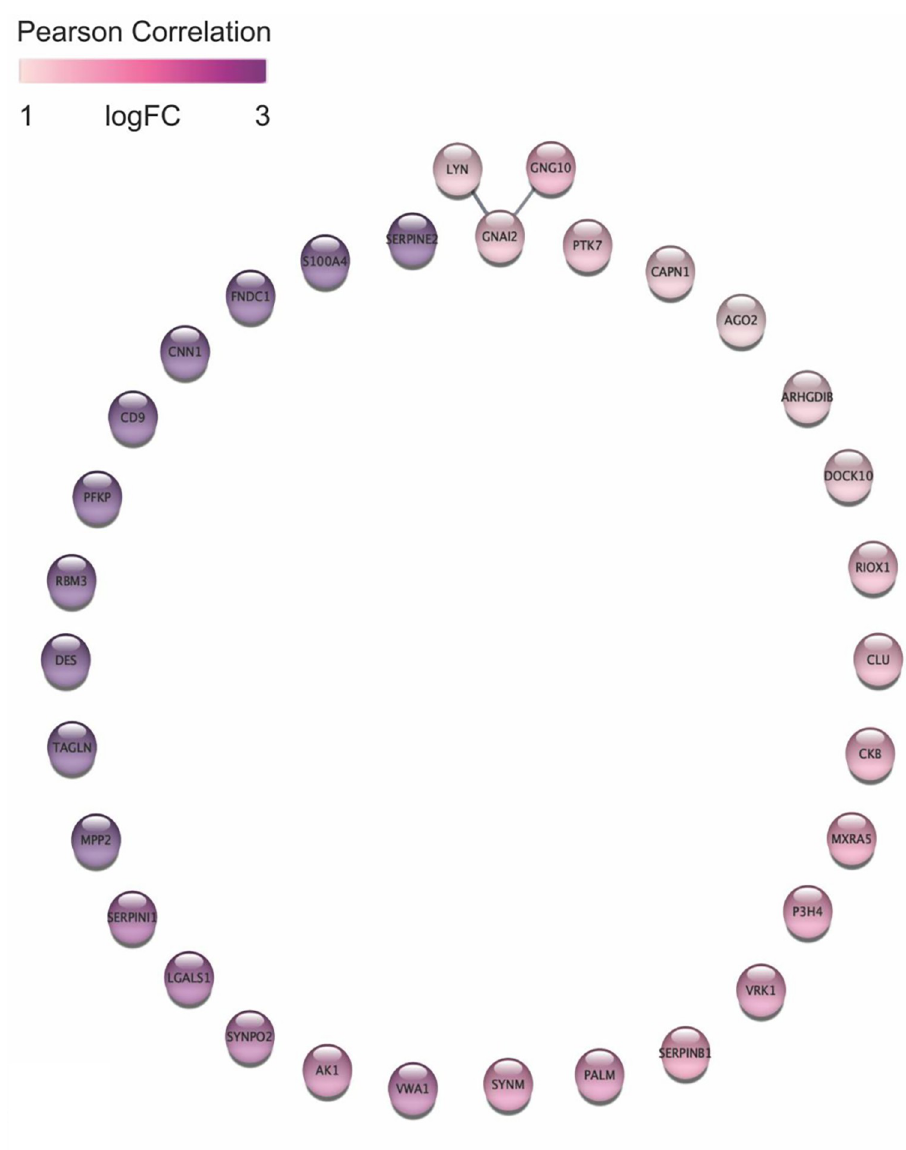
Fig 5. All differentially expressed upregulated proteins with STRING network in canine hepatobiliary NEN. Log- ratios of protein abundance between cancer and normal tissues were mapped using a white-purple gradient. STRING network confidence cutoff is 0.7. Image generated in Cytoscape